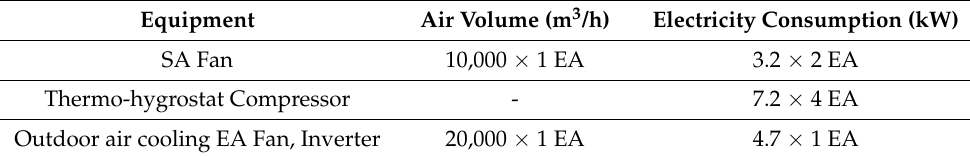
Table 2. Capacity model of the outdoor air-cooling system and thermo-hygrostat.